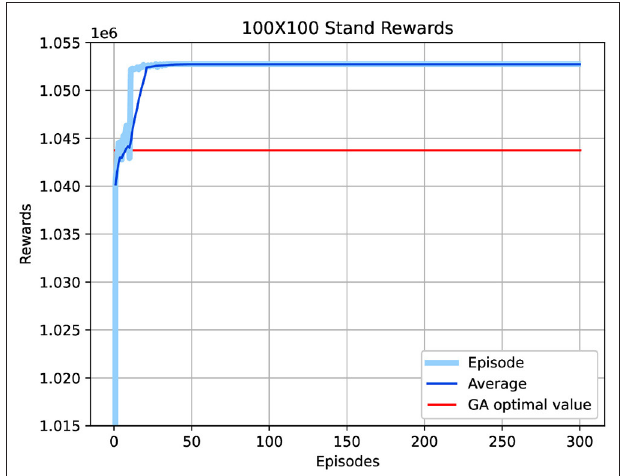
100 stands case compared ×